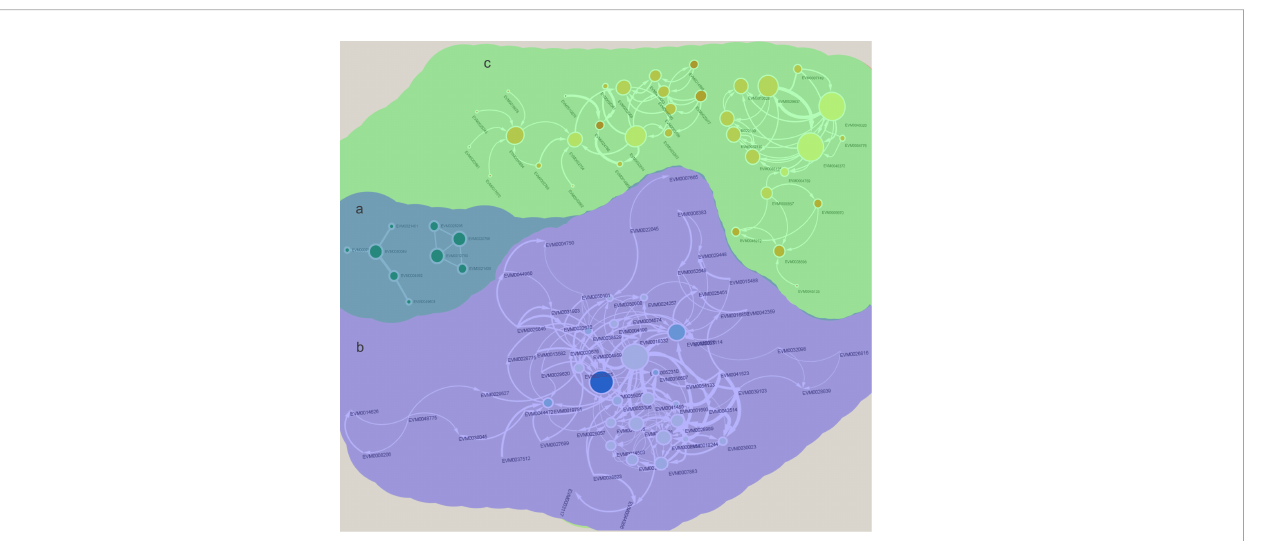
FIGURE 5 Identify of salinity stress responding protein interaction networks in Salix matsudana (Koidz) females and males. (A) Common protein interaction network in both females and males. (B) Male unique salinity stress responding protein interaction network. (C) Female unique salinity stress responding protein interaction